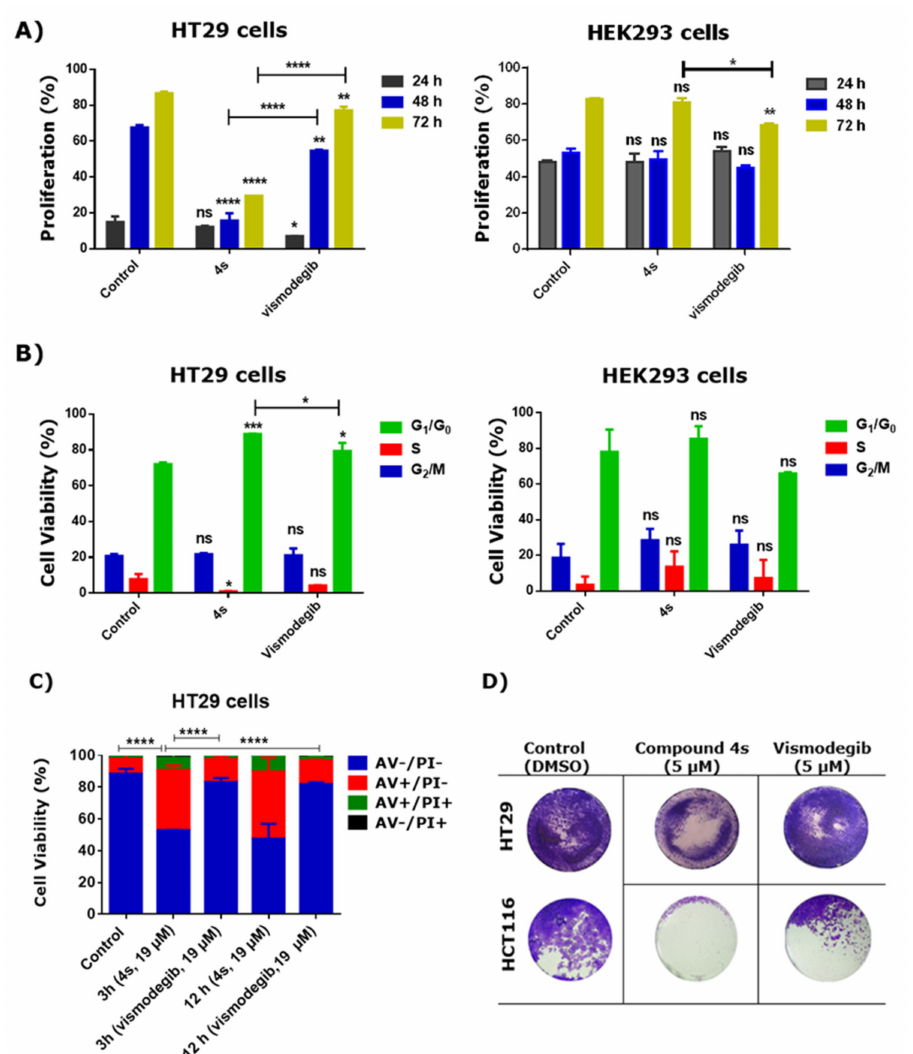
Figure 3. Effects of 4s on cell proliferation, cell cycle arrest, apoptosis, and colony formation of cancer cells. HT29 and HEK293 cell lines were treated with 4s or vismodegib for 3, 12, 24, 48 and/or 72 h (19 µ M), depending on the analysis, for ( A ) anti-proliferative effects determined by flow cytometry upon staining cells with 5 µ M CFSE (control); ( B ) DNA content determined by flow cytometry; ( C ) apoptosis determined by flow cytometry after staining with annexin V-FITC/PI; ( D ) effects on colony formation of cancer cells. Cells were treated with 4s or vismodegib (5 µ M) for 14 d. Results of ( A – C ) are presented as mean ± SD of two separate experiments. (*) p < 0.05, (**) p < 0.01, (***) p < 0.001, (****) p < 0.0001 vs. control, ns = non-significant. Data analysis was performed via a 2-way ANOVA Tukey’s multiple comparisons